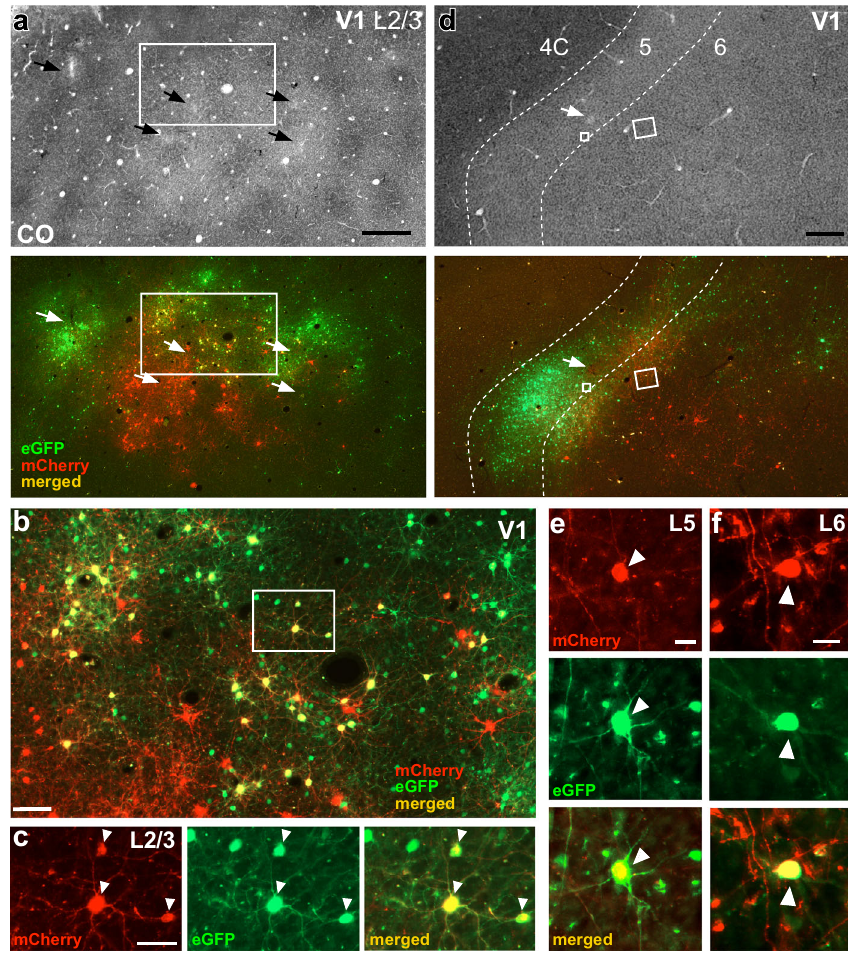
Fig. 2 V1 injection sites. a Case MK405. Image of a single tangential section through V1 L2/3 stained for CO (Top) after being imaged for mCherry and GFP fl uorescence (Bottom). The merged channel shows double-labeled (yellow) “ starter ” V1 → V2 cells. Arrows point to the V1 injection sites in both sections. The region inside the white box is shown at higher magni fi cation in panel ( b ). Scale bar: 500 µ m. b Higher magni fi cation of the V1 region inside the box in panel ( a ). Red cells: V1 → V2 neurons co-infected with CAV2 and AAV9-TVAmCherry, but not with RV dG . Yellow cells: starter V1 → V2 cells double-labeled due to triple infection with CAV2-Cre, AAV9-TVAmCherry, and RV dG -GFP. Of these double-labeled cells only those that were additionally infected by AAV9-oG act as “ starter ” cells. Green cells: cells sending monosynaptic input to the starter V1 → V2 cells (but some local V1 green label is due to TVA “ leak ”— see Results and Supplementary Fig. 2). Scale bar: 100 µ m. Cells in the boxed region are shown at higher magni fi cation in panel ( c ). c Higher magni fi cation of 3 double-labeled V1 → V2 cells (arrowheads) shown under mCherry (Left) or GFP fl uorescence (Middle), and merged (Right). Scale bar: 50 µ m. d Image of a single tangential section through V1 L4C-6 stained for CO (Top) and imaged for fl uorescent signals (Bottom) in the same case as in ( a – c ). Yellow cells inside the small and large white boxes are shown at higher magni fi cation in panels ( e ) and ( f ), respectively. Dashed contours delineate layer boundaries, and layers are indicated at the top. Scale bar: 500 µ m. e , f V1 → V2 starter cells (arrowheads) in L5 ( e ) and L6 ( f ), shown under mCherry (Top) or GFP (Middle) fl uorescence, and merged (Bottom). Scale bars: 20 µ m. Results in ( a – f ) are representative of injection sites made in three independent cases with similar